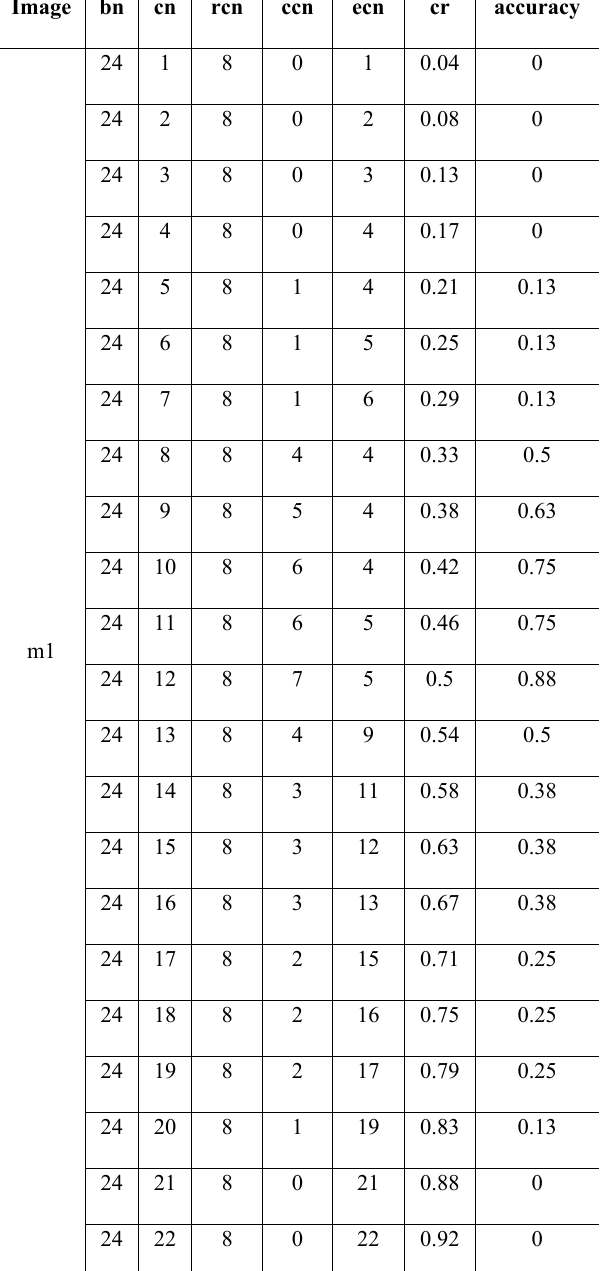
Table 1. m1 parameter index statistics